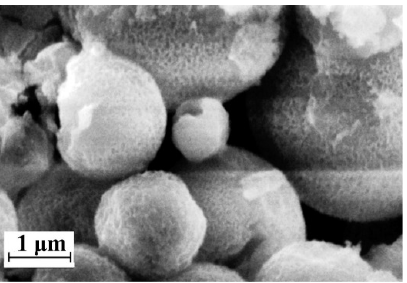
Figure 3. Scanning electron microscopic observations of aerosol powders made of a working solution in which the source of yttrium cations was yttrium nitrate hexahydrate. X-ray phase analysis showed (Figure 4) that the formation of the required phase in particles proceeds incompletely. In addition to the Y 3 Al 5 O 12 phase, they contain a small percentage of the YAlO 3 phase, as well as a significant amount of the amorphous phase.